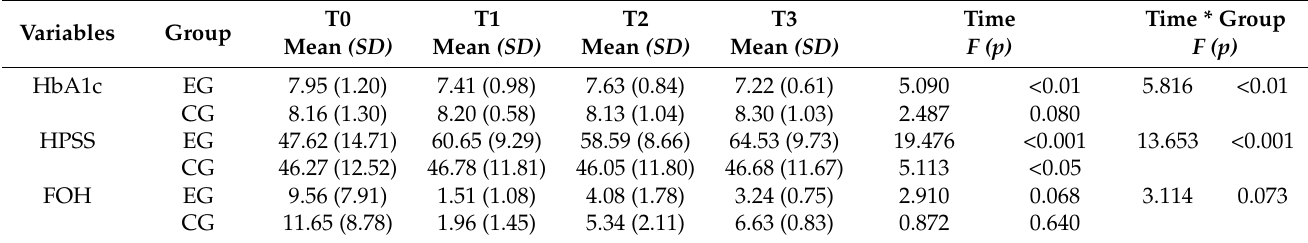
Table 3. Repeated-measures analysis results for HbA1c level and HPSS scores by group (N =